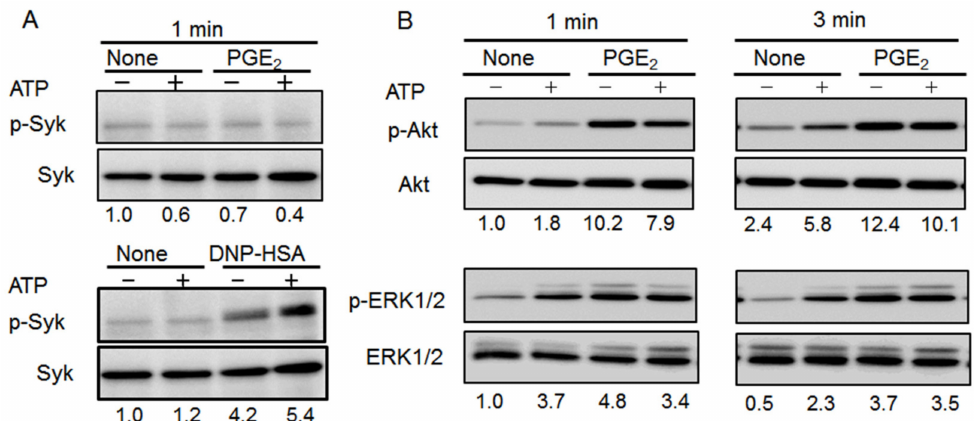
Figure 5. E ff ect of co-stimulation with ATP and prostaglandin (PG)E 2 on Syk, extracellular signal-regulated kinase (ERK)1 / 2, and Akt phosphorylation in bone marrow-derived mast cells (BMMCs). ( A ) BMMCs were stimulated with ATP (100 µ M) with or without PGE 2 (1 µ M, upper) or 2,4-dinitrophenyl human serum albumin (DNP-HAS,10 ng / mL, lower) for 1 min. Cell lysates were subjected to western blot analysis for phospho-Syk and total-Syk. ( B ) BMMCs were stimulated with ATP (100 µ M) with or without PGE 2 (1 µ M) for 1 (left) or 3 (right) min. Cell lysates were subjected to western blot analysis for phospho-Akt and total Akt (upper) or phospho-ERK 1 / 2 and total-ERK 1 / 2 (lower). The numbers below each image indicate normalized relative phosphorylated protein intensity; the results for no stimulation are set to one. Blots are representative of three independent